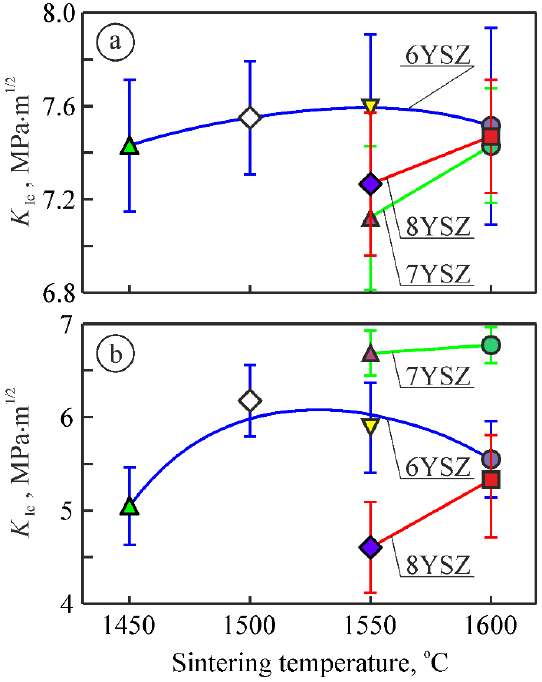
Figure 5. Changes in fracture toughness of 6YSZ, 7YSZ, and 8YSZ ceramics depending on the sintering temperature (see Table 1): ( a ) Vickers indentation method under the indentation load of 9.81 N; ( b ) SENB method under three ‐ point bending.